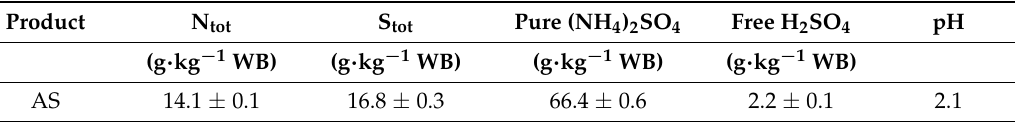
Table 2. Composition of ammonium sulphate (AS) from the farm scale bio-refinery.